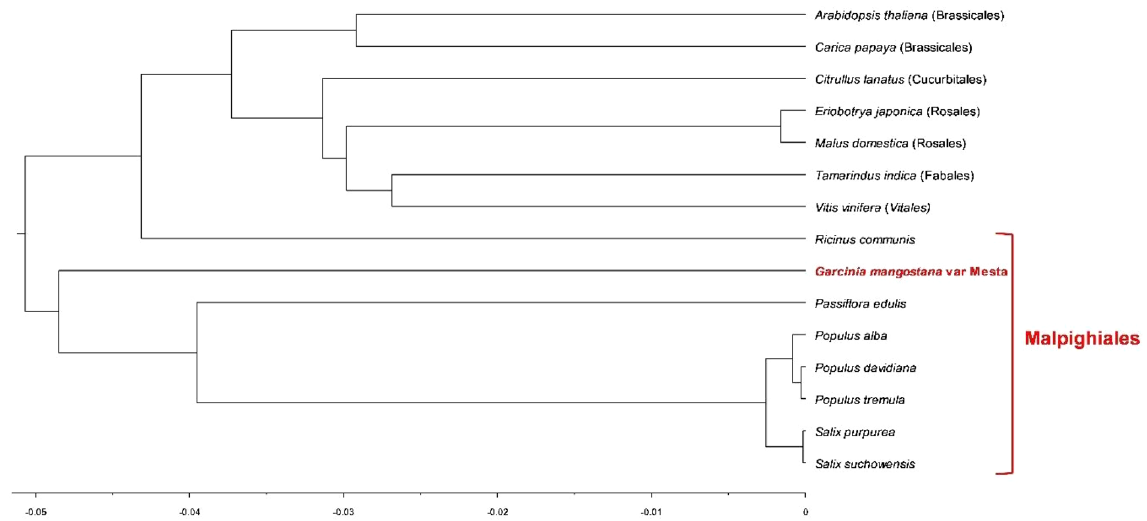
Figure 4. Phylogenomic tree derived from BEAST for Bayesian phylogenetic analysis based on 22 protein- coding genes. The parentheses and red line indicate the order